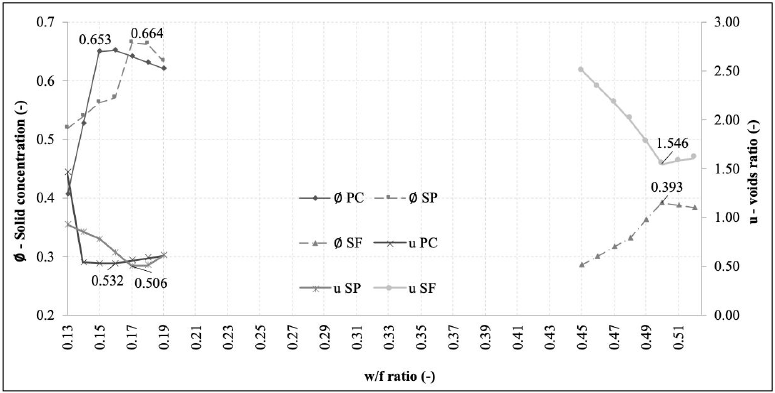
Figure 4. Solids concentration and voids ratio for PC, SP and SF.